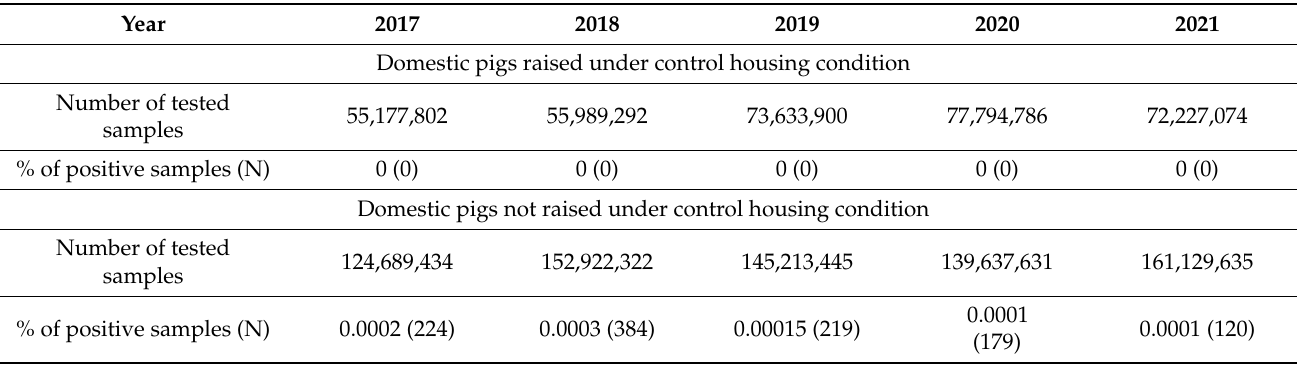
Table 2. Trichinella spp. infections in pigs in EU, as reported by EFSA, between 2017 and